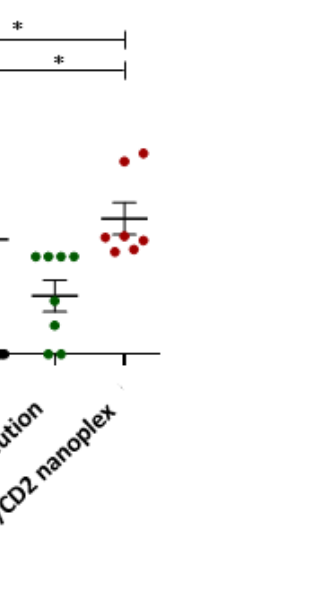
Figure 12. The primary tumor focal area in the treated groups with PBS, 5-FU solution, 5-FU+IL-2 solution and 5FU/IL2/CD2 nanoplex (* p < 0.05).